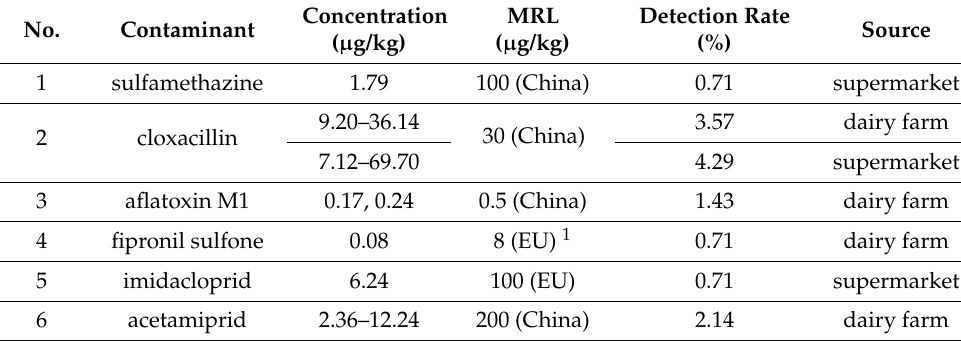
Table 1. The analytical results from 140 milk